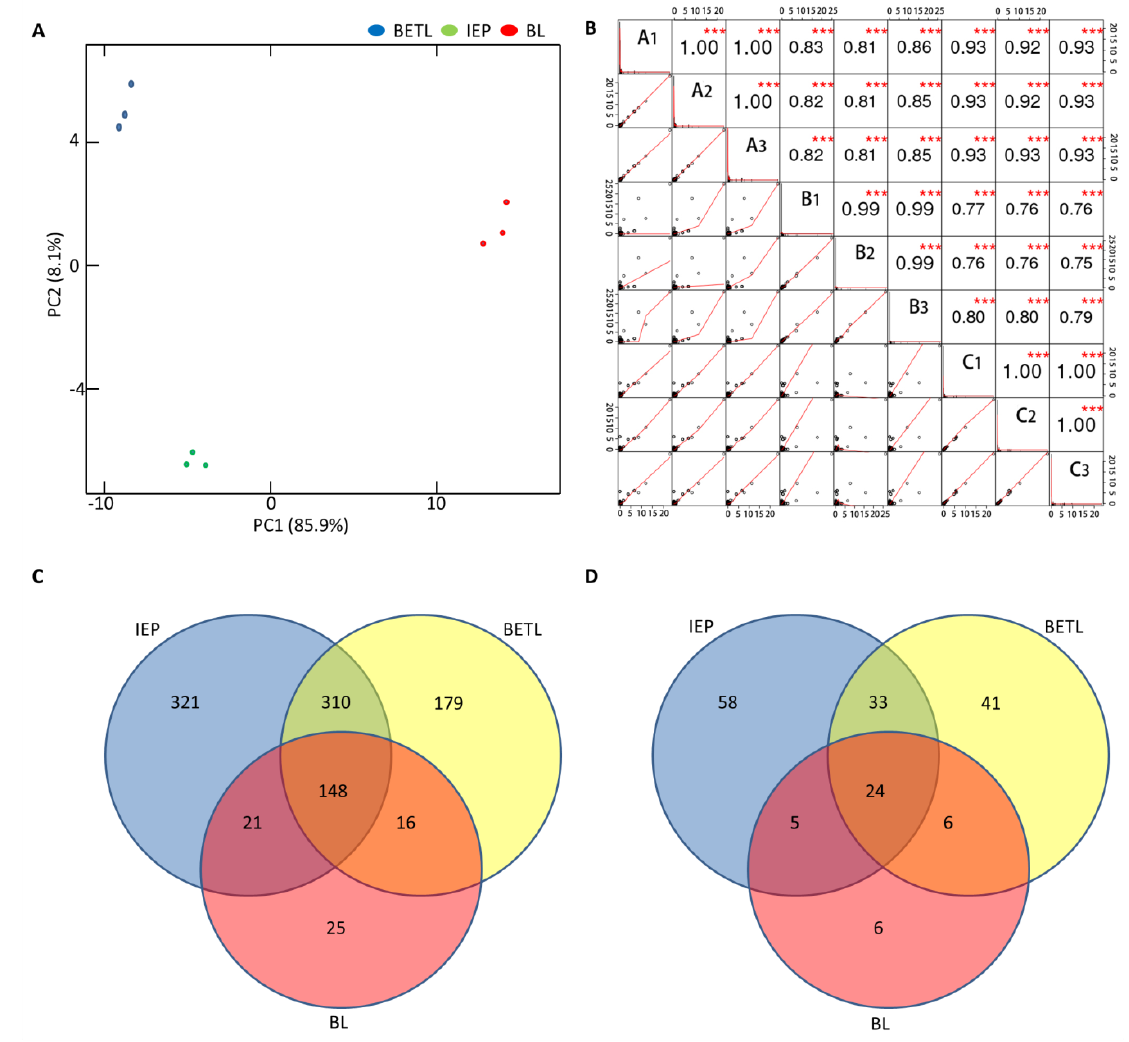
Figure 3. Proteomic analysis of peptides and protein identified from the black layer (BL), inner epidermis of pedicel (IEP), and basal endosperm transfer layer (BETL), of maize kernel 20 DAP. ( A ) Principle component analysis (PCA) of the identified peptides from the three replicated samples of IEP, BL, and BETL; ( B ) Coefficiency correlation analysis of the identified peptides from the three replicated samples of IEP, BL, and BETL. A (1, 2, 3), B (1, 2, 3), and C (1, 2, 3) represent the three replicates of IEP, BL, and BETL, respectively. ( C ) Venn diagram of the identified peptides from IEP, BL, and BETL. ( D ) Venn diagram of the identified proteins from IEP, BL, and BETL. The 1020 peptides represented 173 nonredundant protein entrances (Table S2). Among